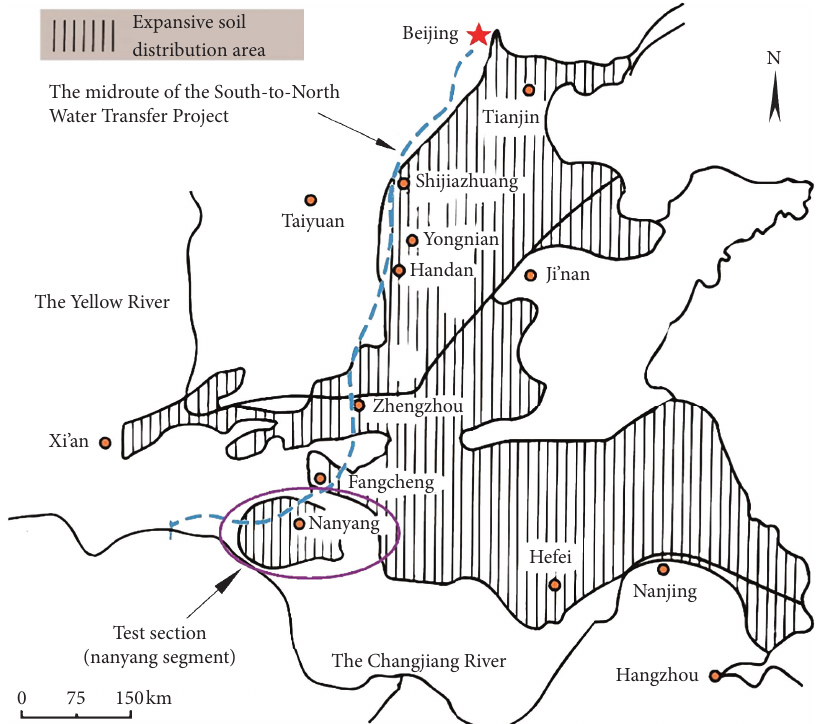
Figure 1: Expansive soil distribution in the midroute of the South-to-North Water Transfer Project of China [3].